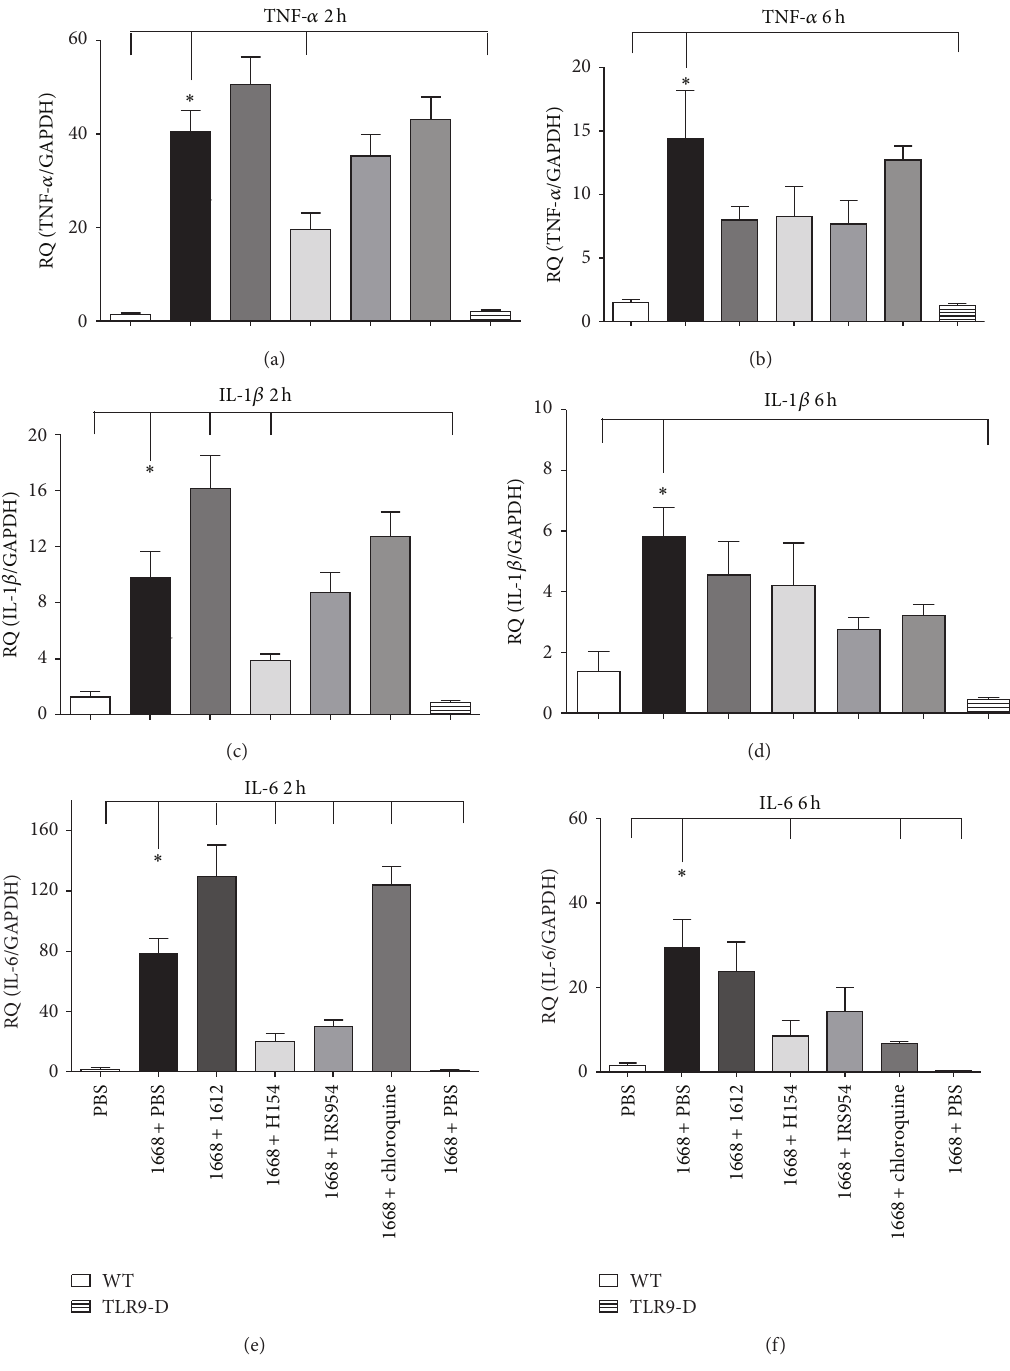
Figure 3: (a)–(f) RT-qPCR of mRNA expression of proinflammatory cytokines TNF- 𝛼 , IL-1 𝛽 , and IL-6 in the hearts of WT and TLR9-D mice measured 2 and 6h after application of 1668-thioate. The control ODN 1612-thioate or the TLR9 inhibitors H154- and IRS954-thioate as well as chloroquine were injected 30 min after stimulation. PBS application served as control, and TLR9-D animals (last bar) were stimulated with 1668-thioate + PBS as negative control (mean ± SEM; 𝑛 = 8 /group, ∗ 𝑃 < 0.05 ; ∗ also indicates the significant group).